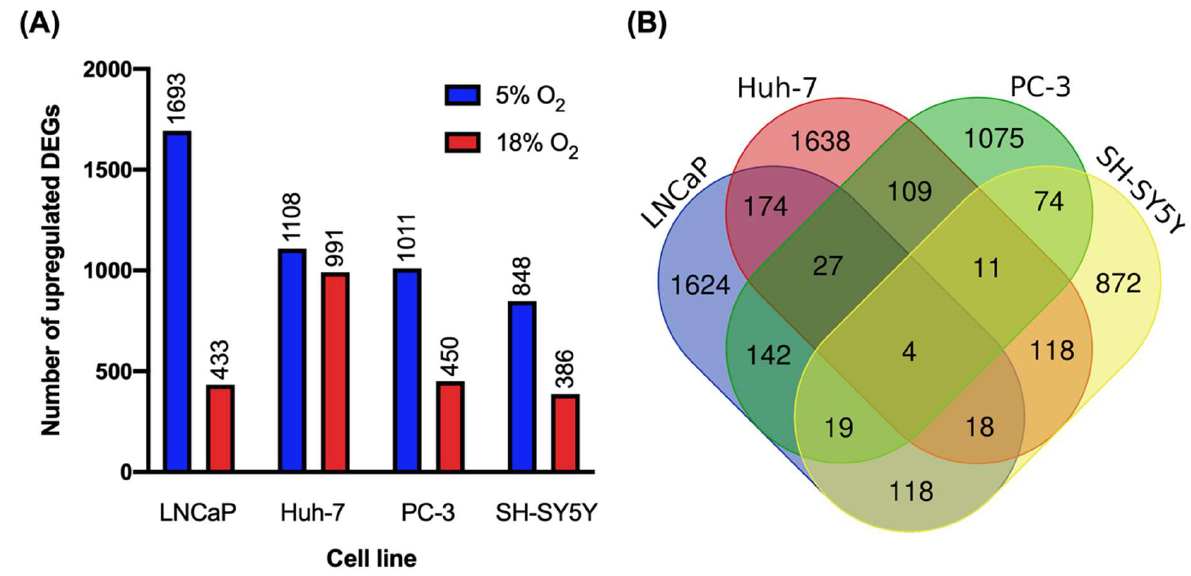
Figure 1. (A ) Number of differentially expressed genes (DEGs) upregulated at 5% and 18% O 2 in each cell line. ( B ) Venn diagram showing the overlap of all DEGs affected by O 2 among the cell lines.